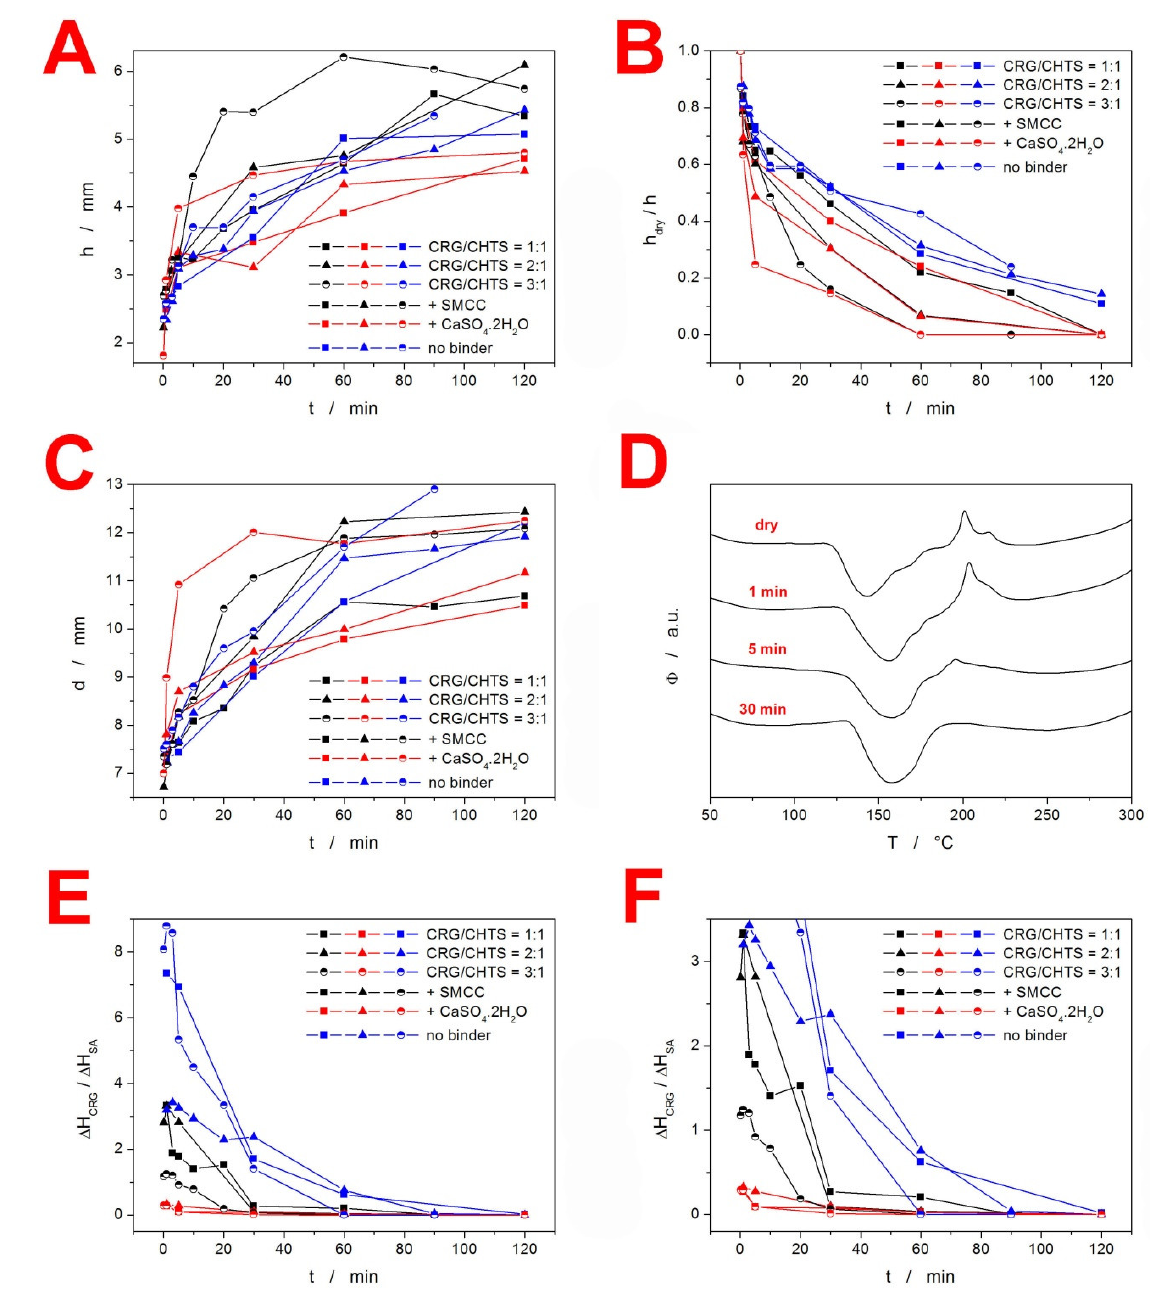
Figure 3. ( A ) Evolution of the tablet height h (measured in the cross-section view) during the dissolution in the acidic medium. ( B ) Evolution of the h dry / h ratio (where h dry is the height/thickness of the dry tablet core) during the dissolution in the acidic medium. ( C ) Evolution of the tablet diameter d (measured in the top view) during the dissolution in the acidic medium. ( D ) Example DSC curves for the samples taken from the “dry” F15 tablet core. Duration of the dissolution in the acidic medium is indicated. ( E ) Ratio between enthalpies of the two characteristic DSC peaks (melting for SA and decomposition for CRG). ( F ) A zoomed-in view of the graph in (E). The error bars in all graphs are lower than four times the magnitude of the points.